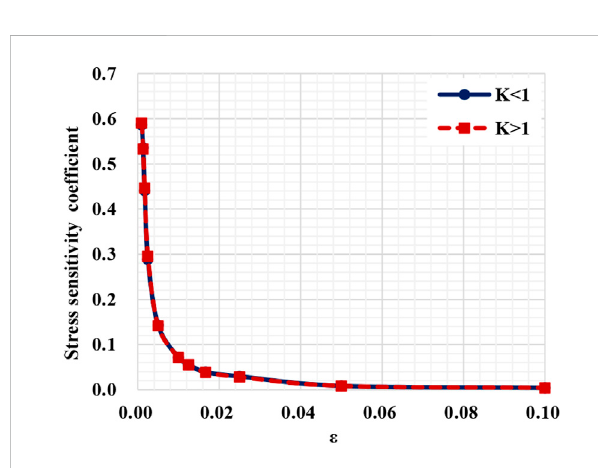
FIGURE 8 Variation of stress sensitivity coef fi cient with the fracture aspect ratio.